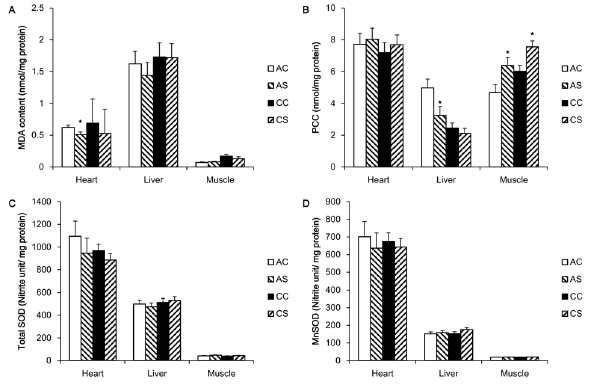
Figure 3. Changes in MDA, PCC and SOD activity after acute and chronic heat challenges. Malondialdehyde (MDA) was used as a biomarker of lipid peroxidation and was determined by the thibabituric acid (TBA) method. Protein carbonyl content (PCC) was employed as a protein oxidation biomarker and was determined using a spectropho- tometric 2, 4-dinitrophenylhydrazine (DNPH) assay. Activities of total superoxide dismutase (TSOD) and MnSOD were measured with the nitrite method. Values are expressed means 6 SE of data from 5–6 individual tissue samples. * indicates significant differences (P , 0.05) between controls and heat-stressed groups. AC, acute control group; AS, acute heat-stressed group; CC, chronic control group; CS, chronic heat-stressed group.